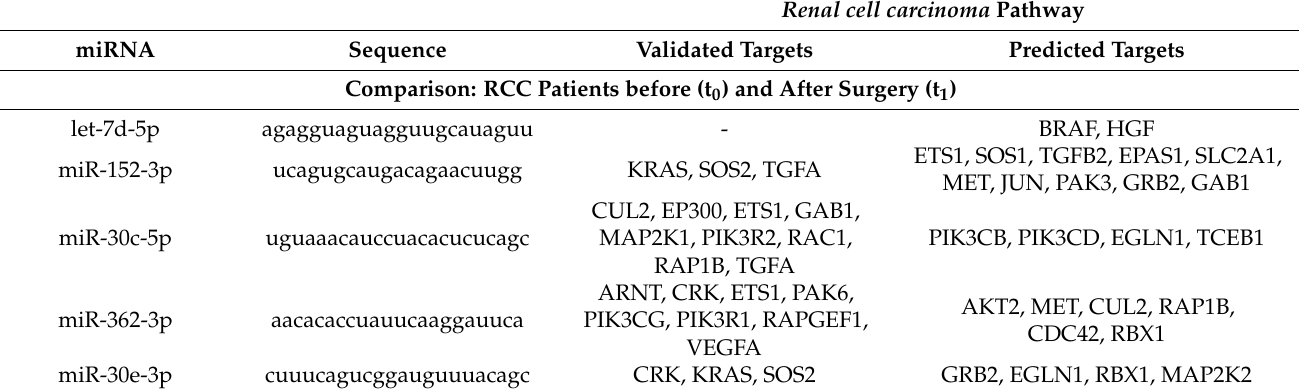
Table 4. Cont. Renal cell carcinoma Pathway Sequence Validated Targets Predicted Targets Comparison: RCC Patients before (t 0 ) and After Surgery (t 1